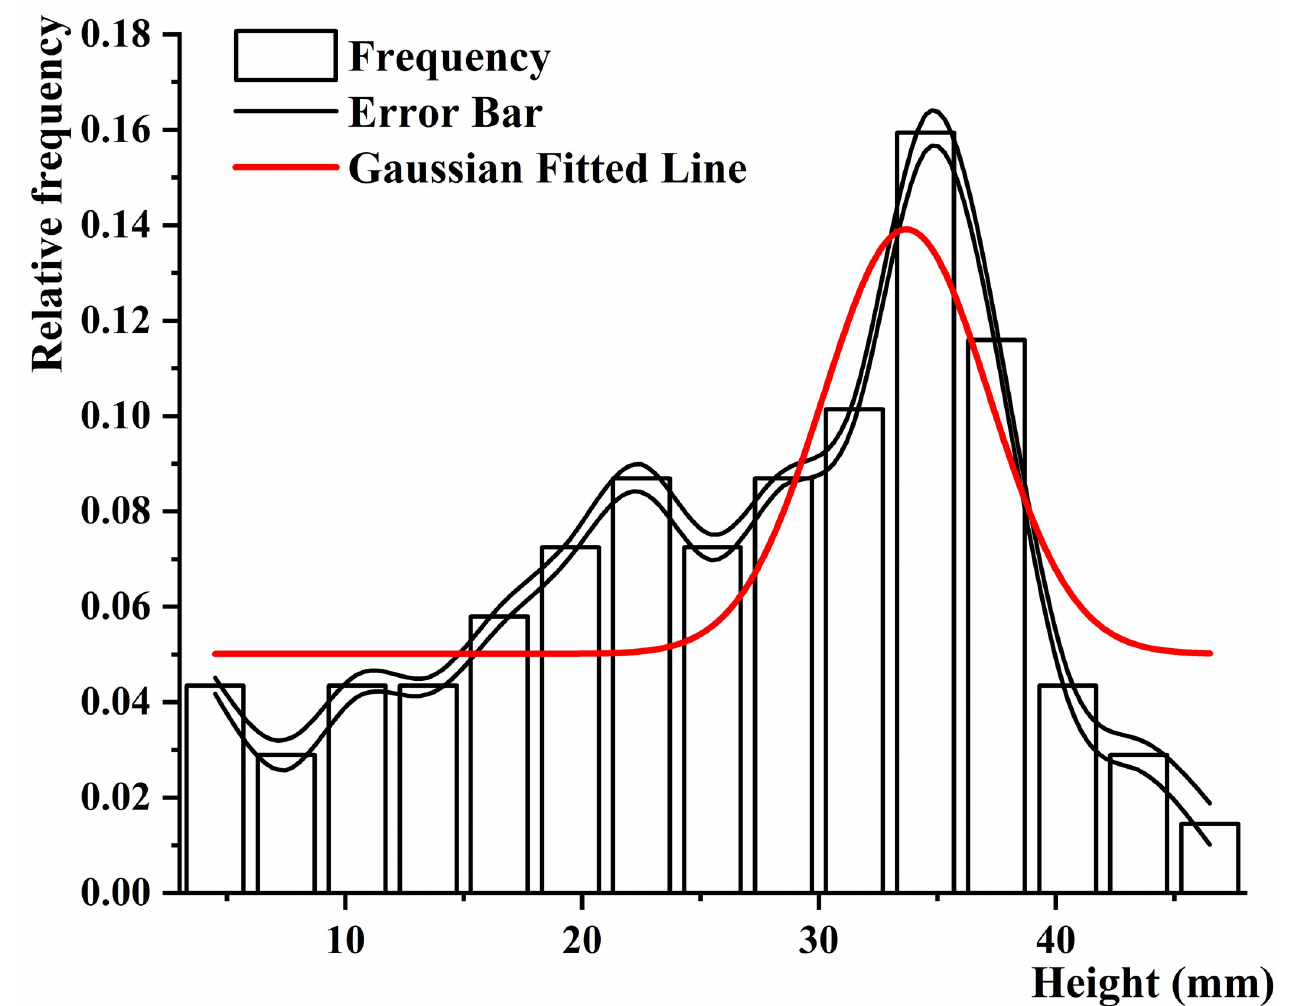
Fig 10. Height distribution of black